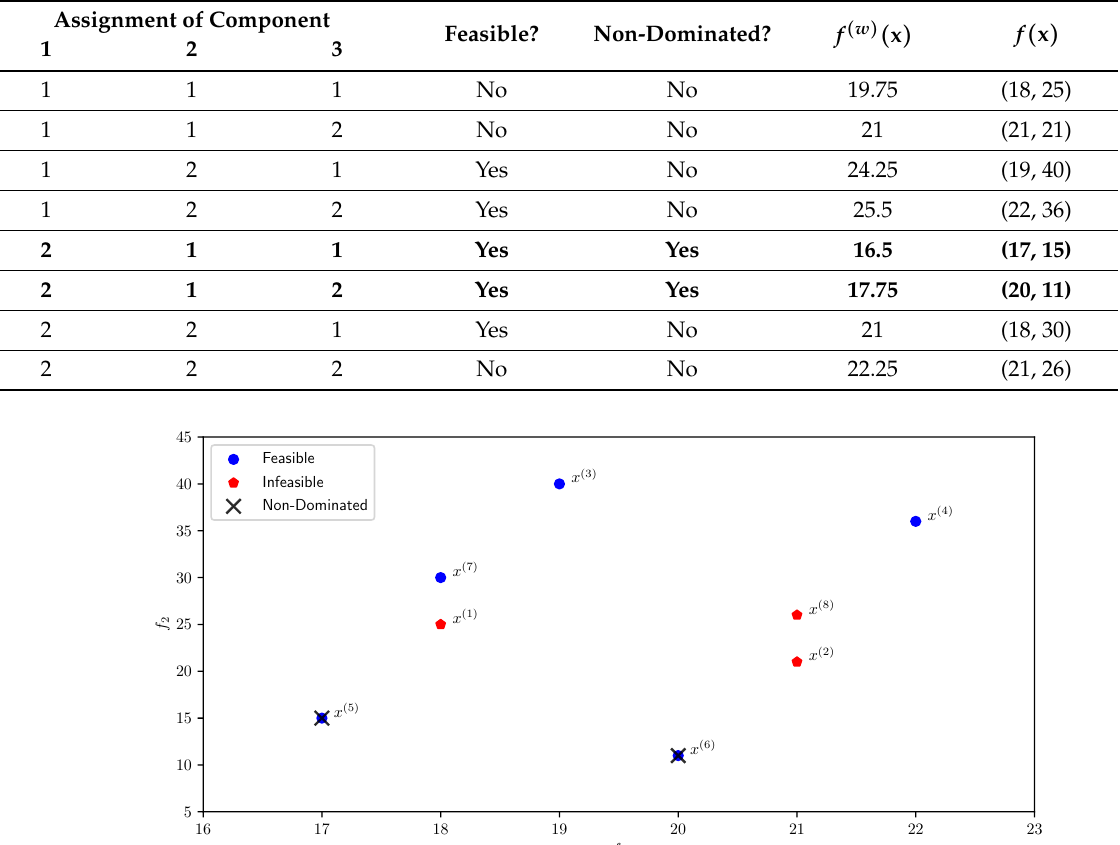
Figure 2. Overview of the objective space showing all eight solutions of the